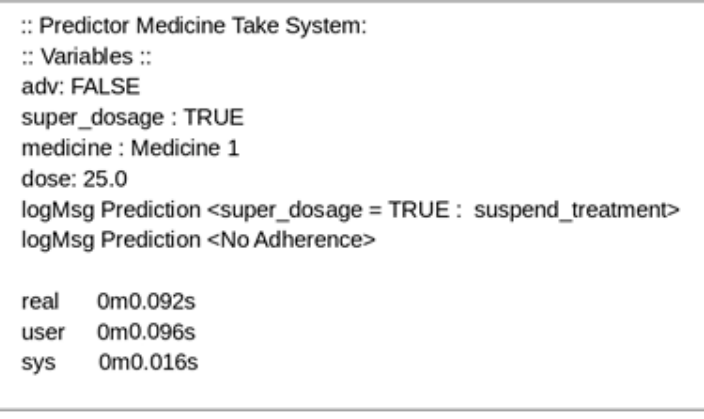
Figure 9. Decision-making system log.